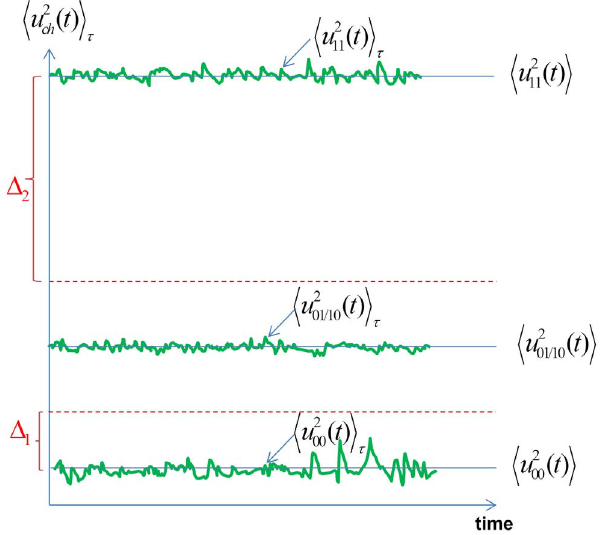
Figure 2. Illustration of the fluctuations of the finite-time mean-square voltage levels around their exact value and thresholds for interpretation (the scale is arbitrary). S u 2 S u 2 ( t ) T t , S u 2 ( t ) T t are the measured mean-square channel noise 00 01 = 10 voltages at the 11, 01/10 and 00 bit situations, respectively. The solid lines with the quantities in ST represent ideal (infinite-time) averages. For the sake of simplicity we assume R 0 ~ R and, R 1 ~ a R with a ww 1 .